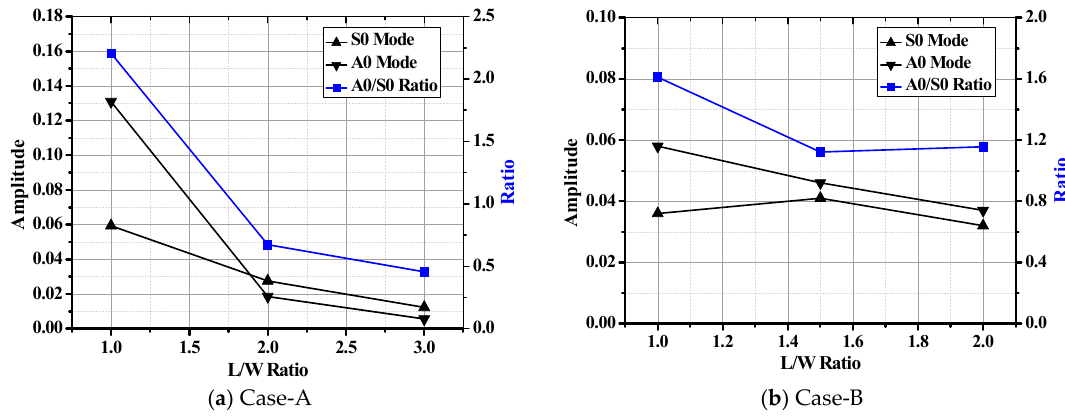
Figure 10. Waveform characteristics and the amplitude tendency in different composite bolted joints after tensile load.